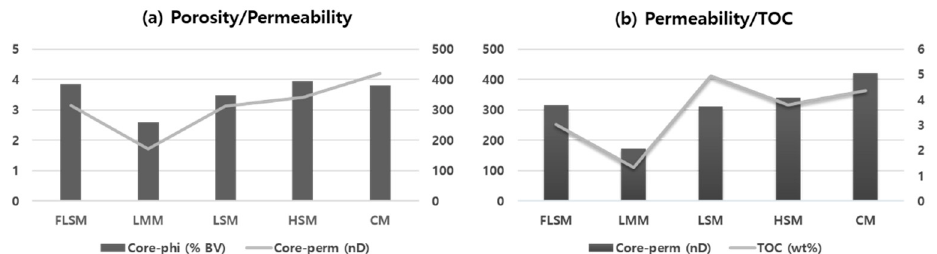
Figure 7. The relationship between lithofacies and ( a ) porosity and permeability, and ( b ) permeability and TOC content, measured by core analysis data of the Horn River Formation.